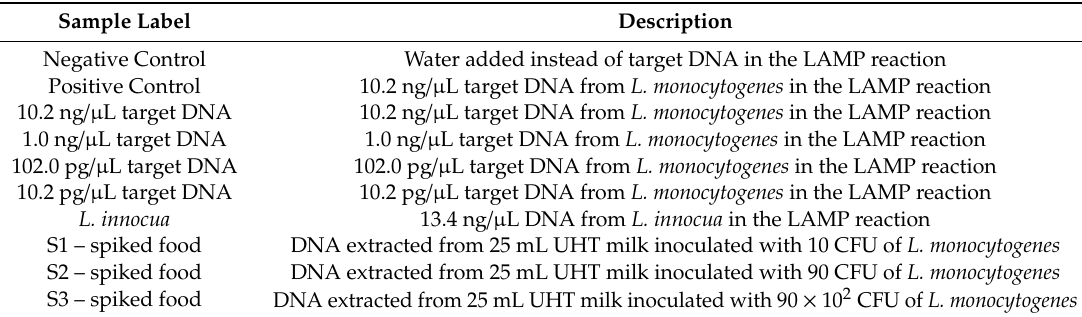
Table 1. Samples analyzed by LAMP-on-a-chip SERS